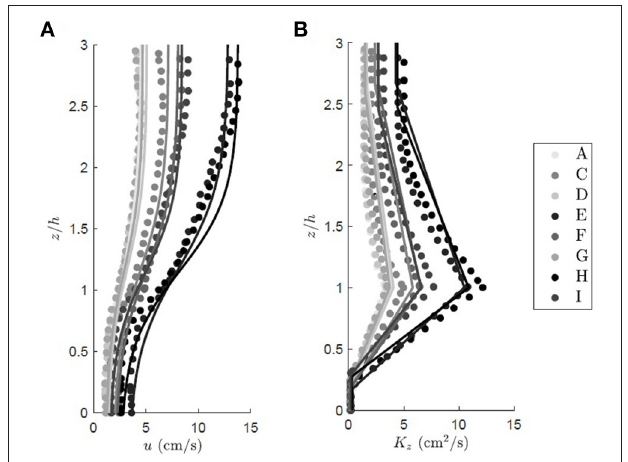
FIGURE 2 | Family of vertical profiles for the (A) time mean longitudinal velocity and (B) eddy diffusivity over a submerged rigid canopy of increasing shoot density. The circles represent the measured values from Ghisalberti and Nepf (2005), and the predicted profiles are shown with solid lines. The colors denote different experimental case. In alphabetical order of experimental run, u 0.45, 0.74, 0.53, 1.33, 0.84, 0.50, 1.57, 0.86, 0.55 cm/s, C D ∗ = 0.77, 0.85, 0.67, 0.71, 0.82, 0.61, 0.66, 0.79, and a 0.040, 0.040, 0.040, 0.080, 0.080, 0.080 cm − 1 . For all cases the canopy height was h 13.9cm and the plant width was L v =